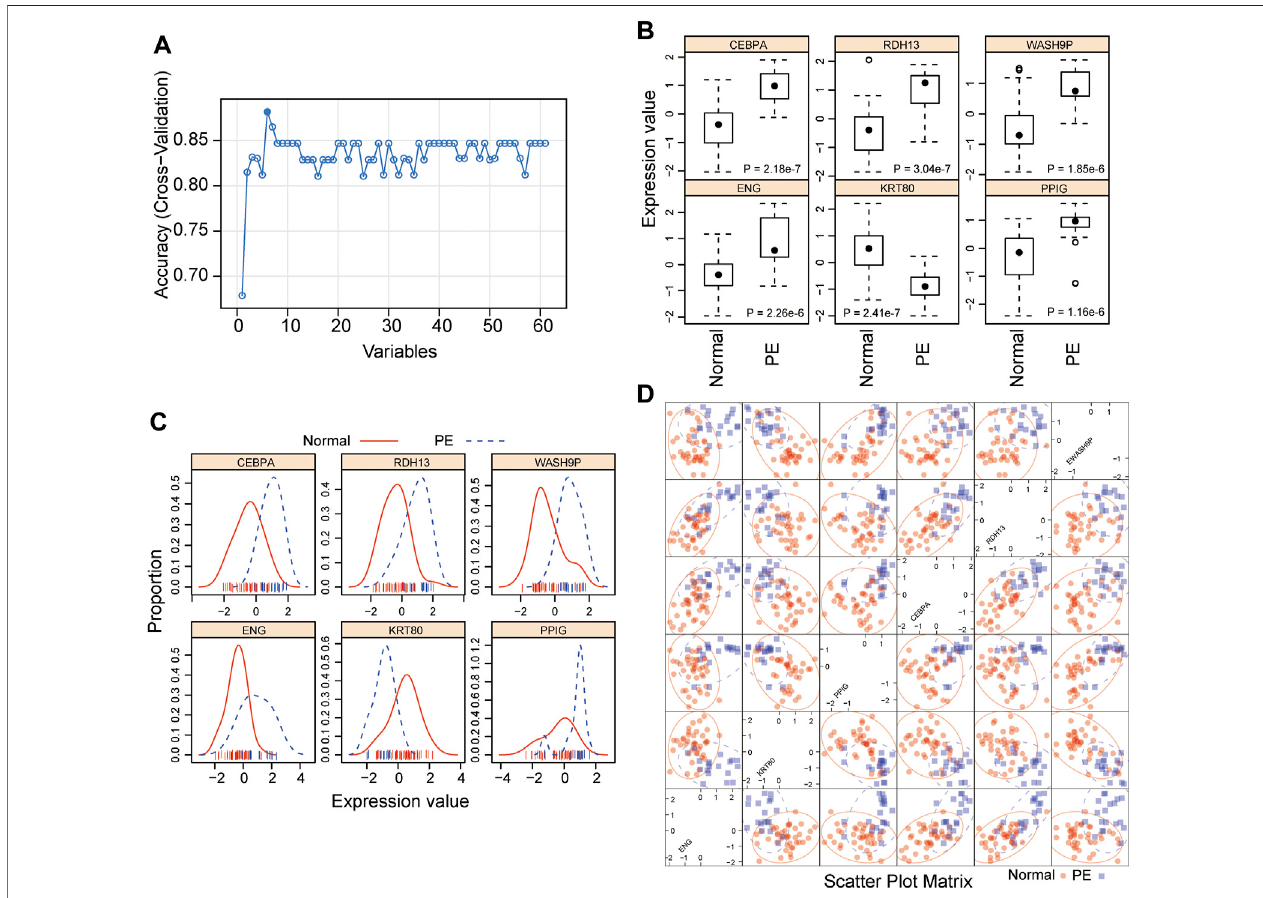
FIGURE3| Developmentofa5-mRNAgenepanelforearlypreeclampsiadiagnosis. (A) Boxplotshowingthepredictedaccuracyofeachcombinationconstructed by a speci fi c number of mRNA biomarkers. (B) Boxplot showing expression levels of six candidate mRNA biomarkers. (C) Distribution of expression levels of six candidate mRNA biomarkers. (D) Scatter Plot showing expression levels of six candidate mRNA biomarkers.